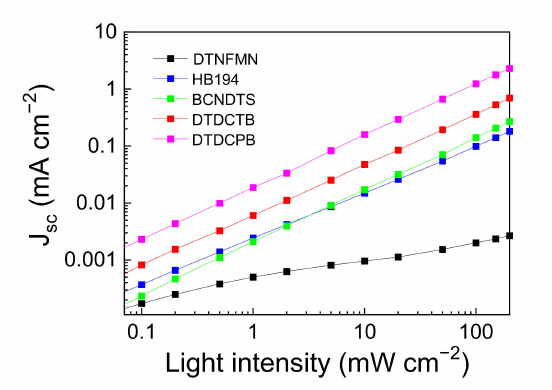
Figure 4. Light intensity dependence of J SC for the single-component